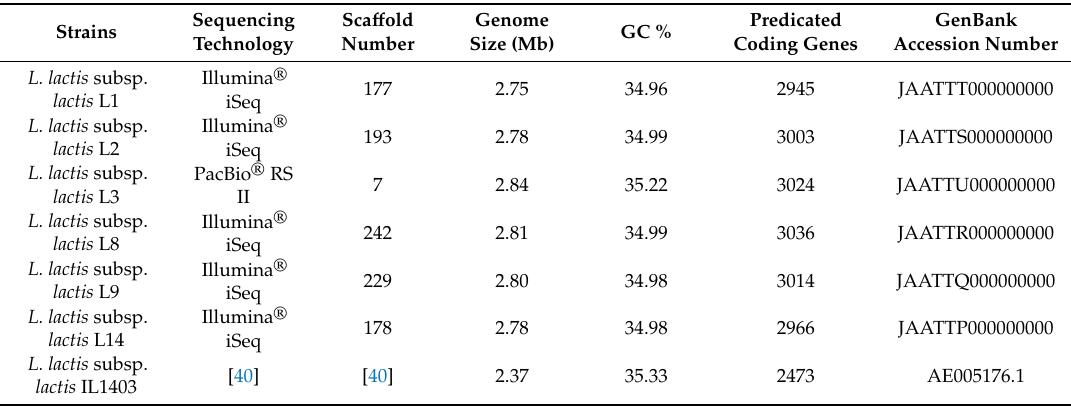
Table 2. Genomic features of subspecies in the genus Lactococcus .